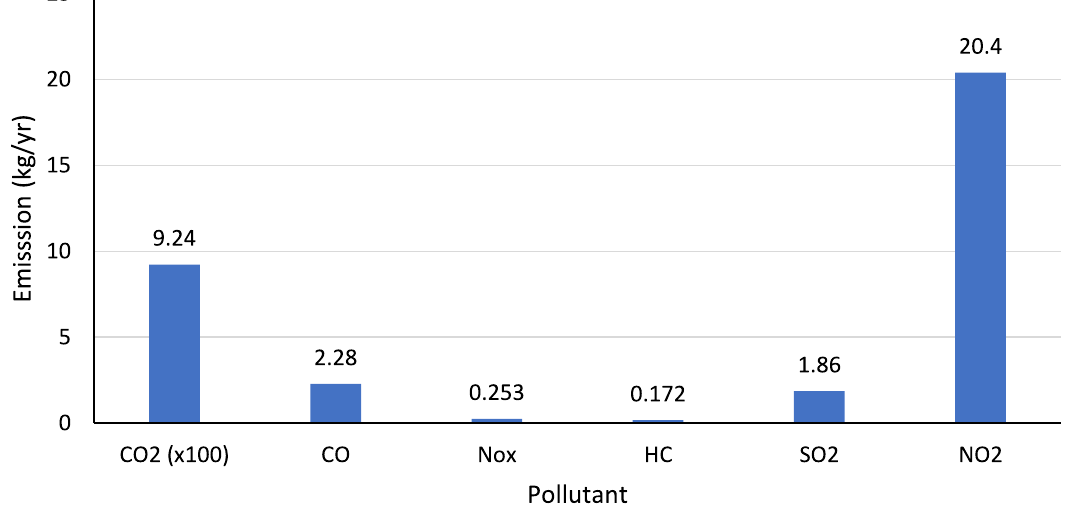
Fig. 6. Polluted emissions produced by equivalent diesel